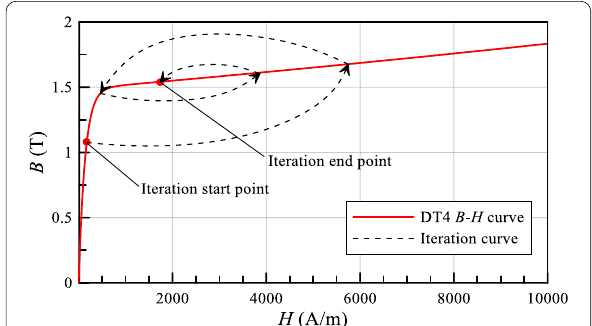
Figure 11 B–H curve of DT4 and iterative